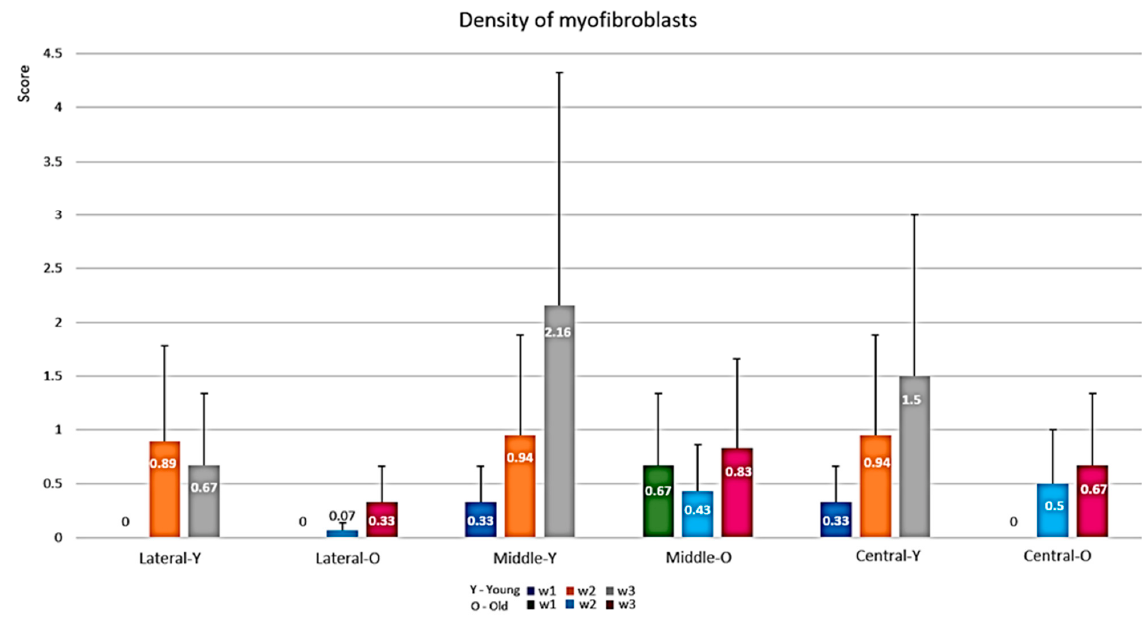
Figure 6. Myofibroblast density score in young and old rats along time.